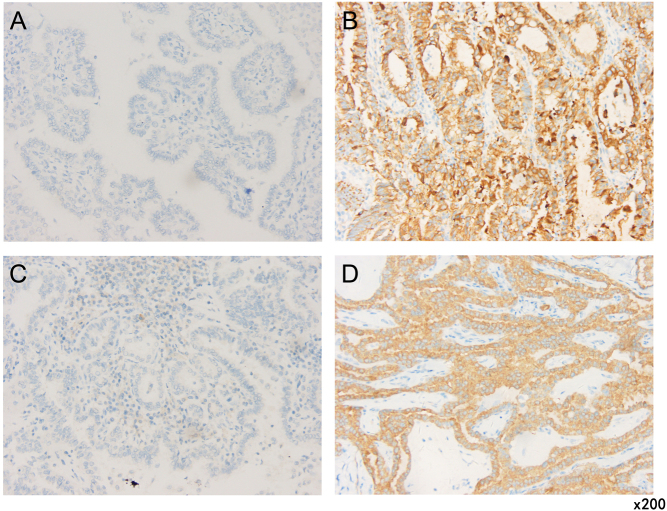
BRAF V600E immunohistochemistry in PTC (×200). (A and C) Non-specific staining in tumor cells (A) and LNM (C), BRAF V600E expression is negative. (B and D) Cytoplasmic staining in tumor cells (B) and LNM (D), BRAF V600E expression is positive. PTC, papillary thyroid cancer; LNM, lymph node metastasis.